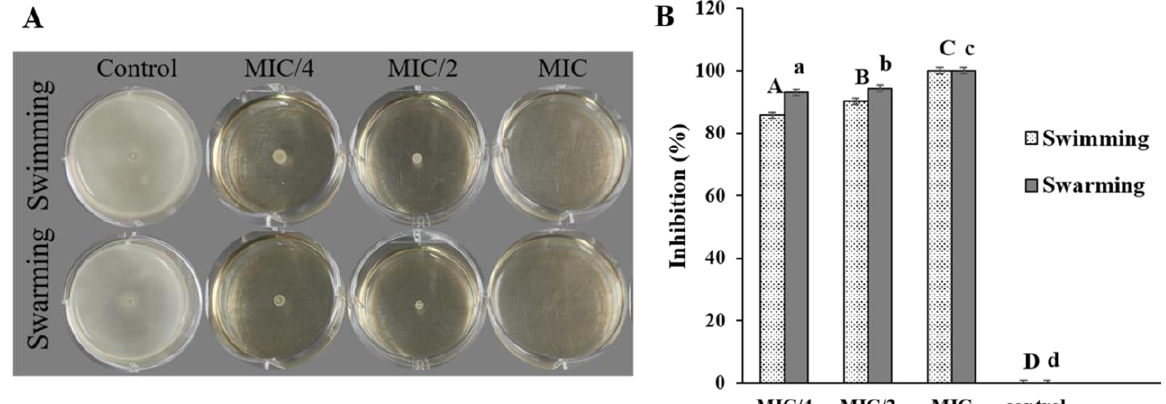
Figure 7. Effect of COS-EGCG conjugate at different concentrations on the mortality; swimming and swarming of L. monocytogenes MIC/4, MIC/2, and MIC, and sterile distilled water were used ( A ) and the percent inhibition of the motility of L. monocytogenes by the COS-EGCG conjugate was reported ( B ). Different uppercase letters and different lowercase letters on the bars for swimming and swarming, respectively, denote significant differences ( p < 0.05).